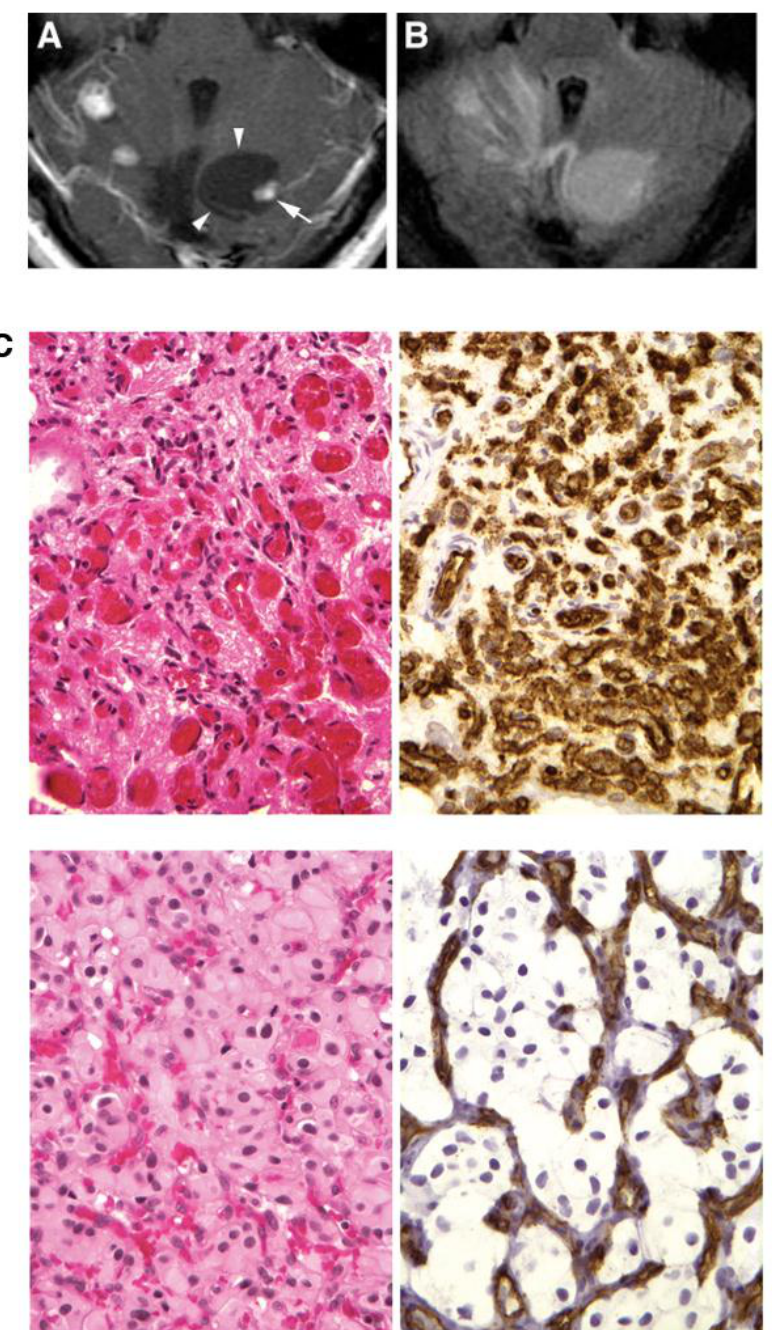
Figure 1. Radiological and histologic presentation of hemangioblastomas. A, T1-weighted postcontrast MR image shows right cerebellar hemangioblastoma (arrow) with an associated cyst (arrowheads); B, corresponding precontrast, fluid-attenuated inversion recovery, MR image demonstrating cyst hyperintensity (from Lonser et al., Ann Neurol 2005;58:392-399). C, Hemangioblastoma may present with mesenchymal (upper) and epitheloid structures (lower); Immunohistochemistry for vascular antigen CD34 reveals reactive vascularization (upper and lower right), neoplastic cells are negative for anti-CD34 (from Shively et al., J Pathol